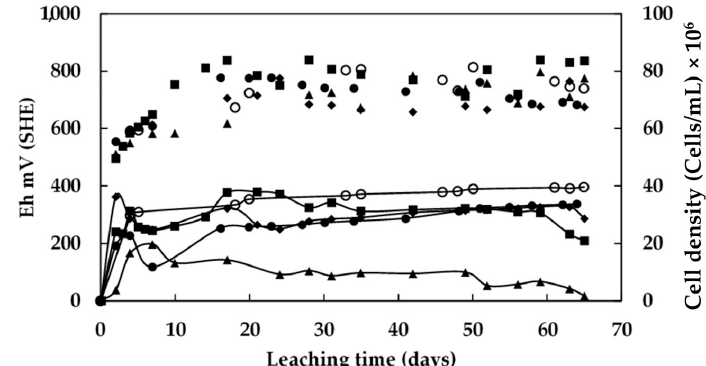
Figure 15. Variation of redox potential in bioleaching solution during copper extraction from chal- copyrite at ambient temperature with different raffinate solutions. The evolution of cell density is also shown (dashed line). ▲ 3.0 g/L of acid, 1.0 g/L total iron and 1.0 7 cells/mL, continuous irrigation,